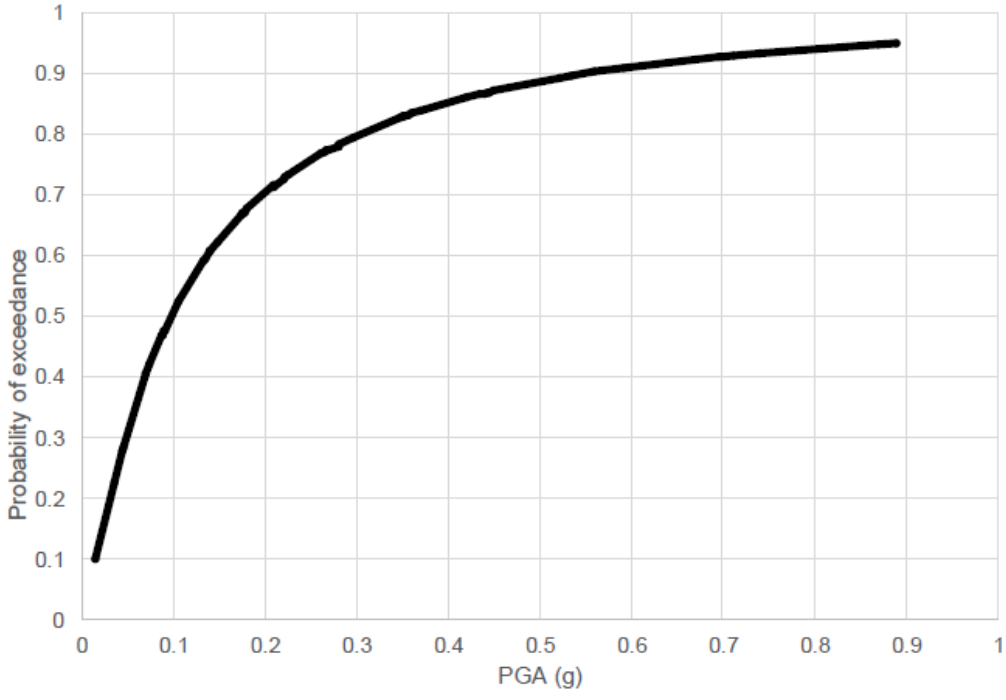
Figure 10. Soil results: relationship between PGA (ln) and settlement (ln).